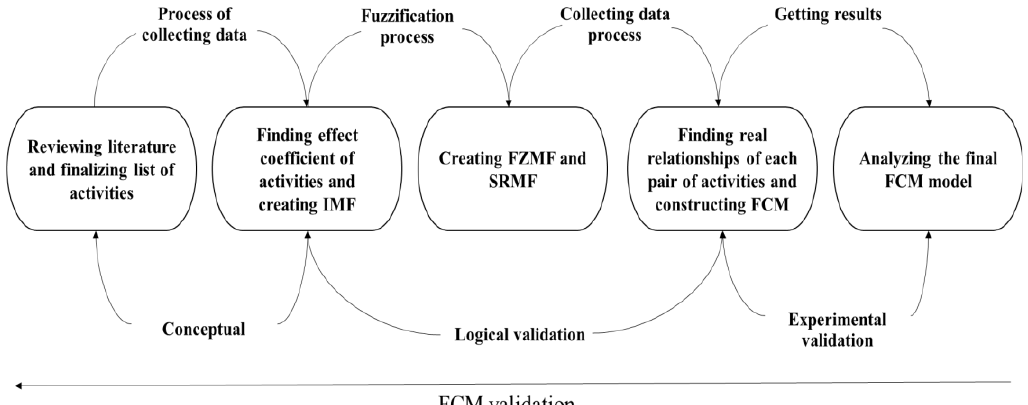
Fig. 2. Summary of FCM construction and validation [8].